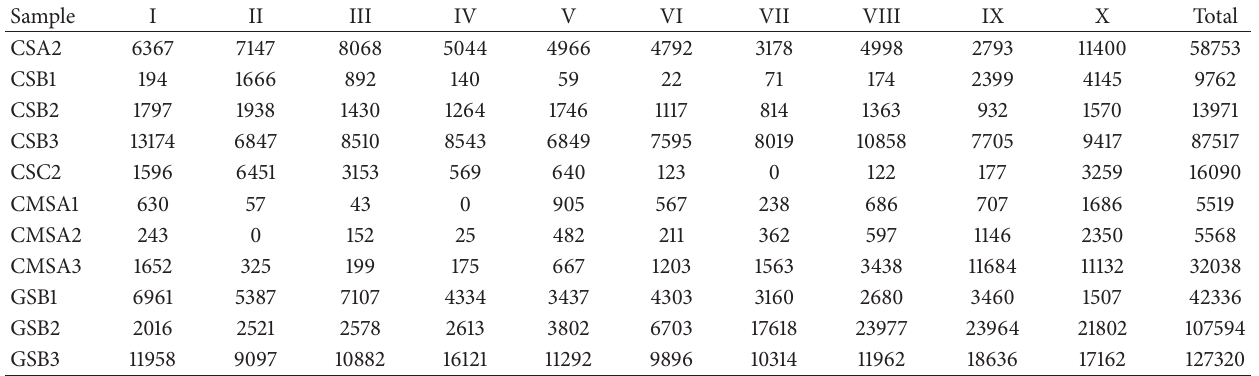
Table 2: Ring count distribution and accumulation in different loading stage.